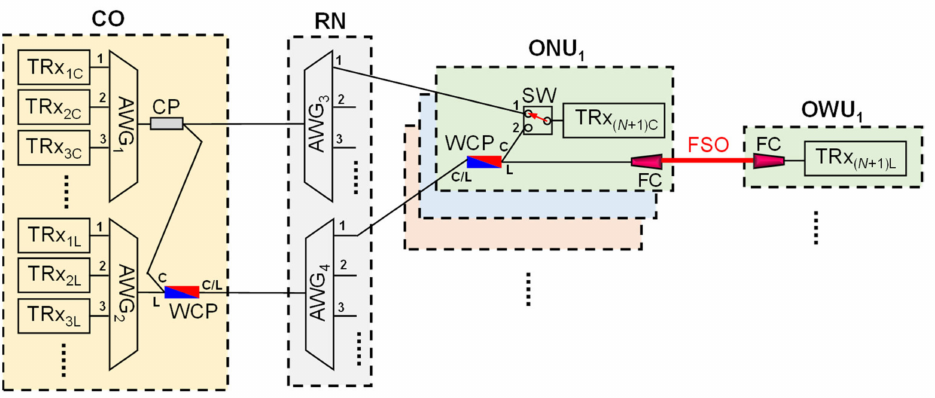
Figure 2. Proposed self-protected WDM-PON system together with fiber and FSO signals for data access against fiber